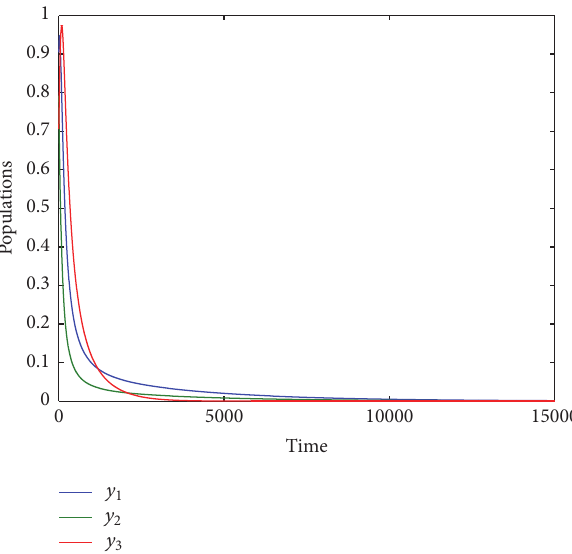
Figure 3: Time series of system (3) approaches asymptotically to the vanishing equilibrium point for 𝑎 3 = 0.85 with other parameters given by